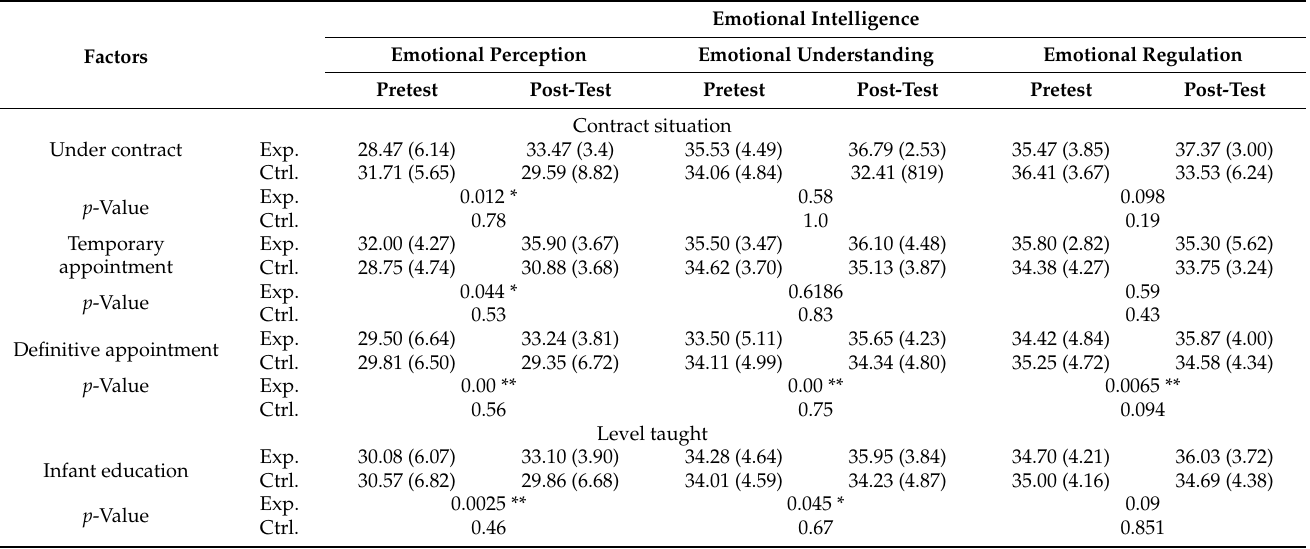
Table 4. Influence of the variables that make up the work profile in emotional intelligence in the control group and in the experimental group from pretest and post-test